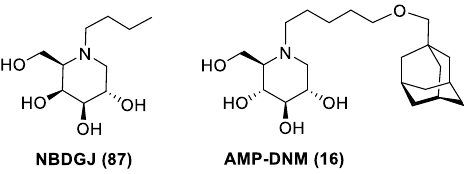
Figure 19. Iminosugars with anti-inflammatory potential.